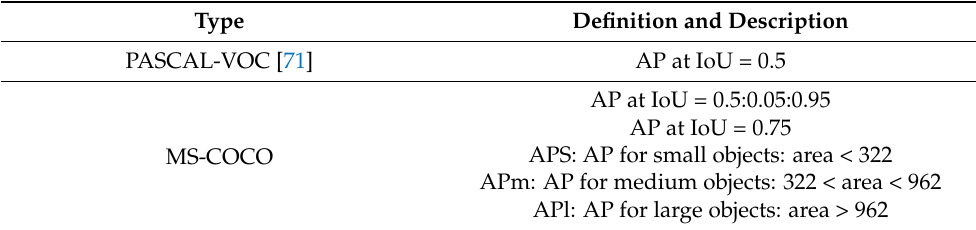
Table 3. Summary of common evaluation metrics for AP